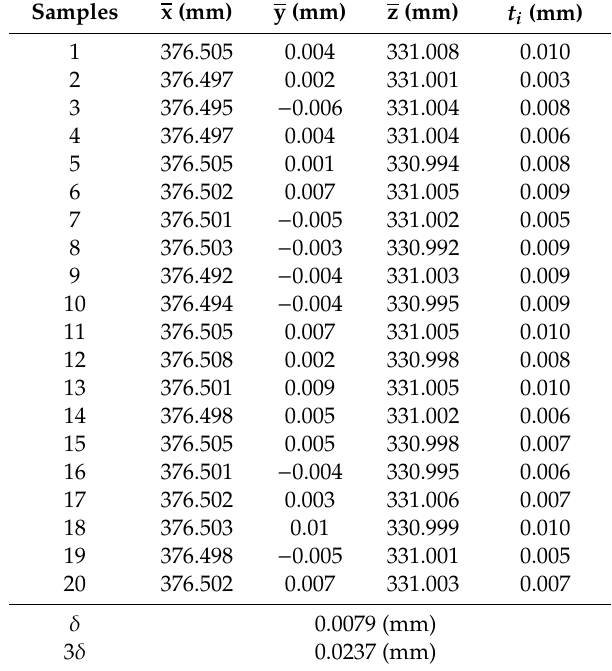
Table 3. Position repeatability of robot